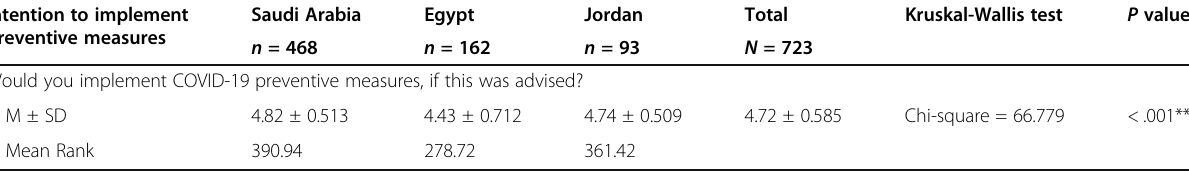
Table 10 Differences in mean “ intention to implement preventive measures ” scores, according to country of origin Intention to implement preventive